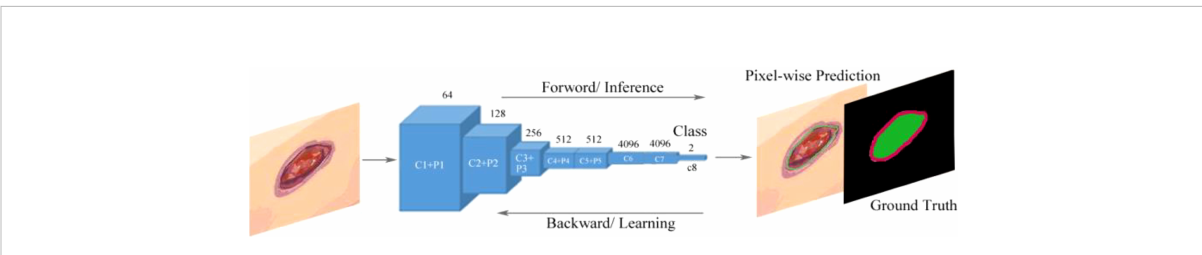
FIGURE 9 Fully convolutional networks (FCNs) for the semantic segmentation of DFUs (50). The model learns features with forward and backward learning for segmentation. C1 – C8 are convolutional layers and P1 – P5 are max-pooling